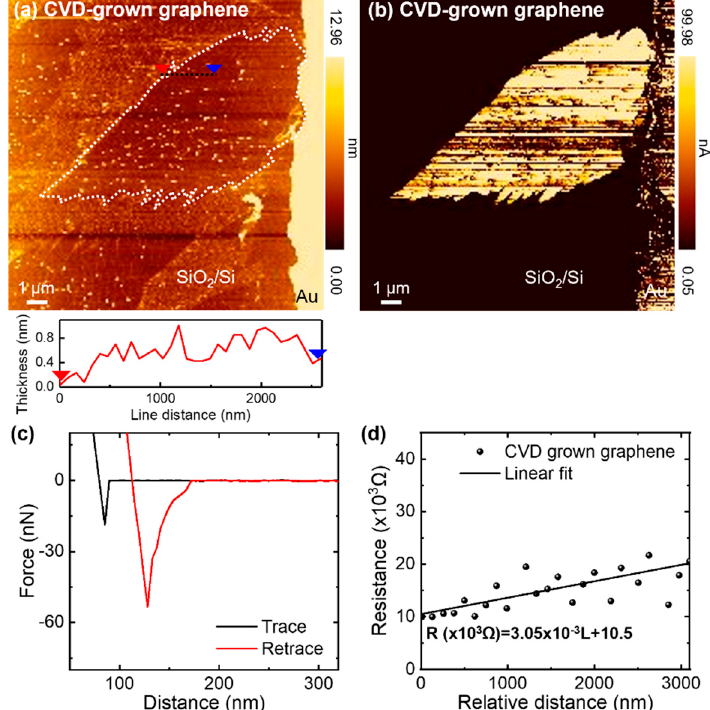
Figure 4. ( a , b ) AFM images for the ( a ) topography and ( b ) current distribution of the CVD-grown monolayer graphene flake on SiO 2 . ( c ) Force–distance curve. ( d ) Resistance profile of the graphene flake as a function of the distance from the tip to the electrode.